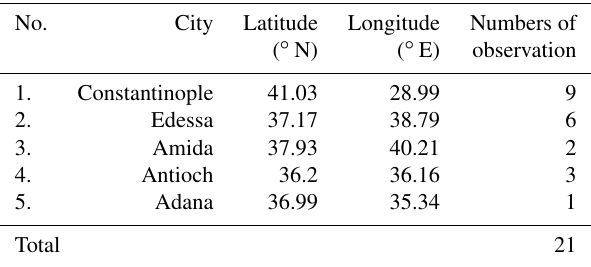
Table 3. The number of historical aurora records observed in Con- stantinople and